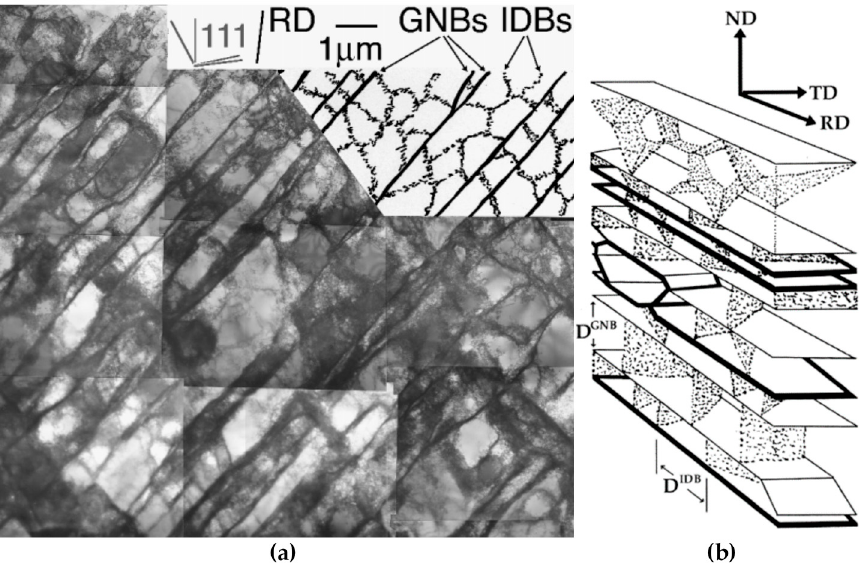
Figure 6. TEM image and the illustration of IDBs and GNBs. ( a ) A TEM image of pure Ni cold rolled to a reduction of 20%; ( b ) An illustration of IDBs and GNBs. (Reprinted from References [73,74], with permission from Elsevier).